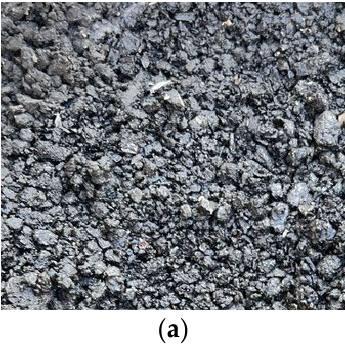
Figure 1. Utilized aggregates: ( a ) RTA and; ( b ) FNA.